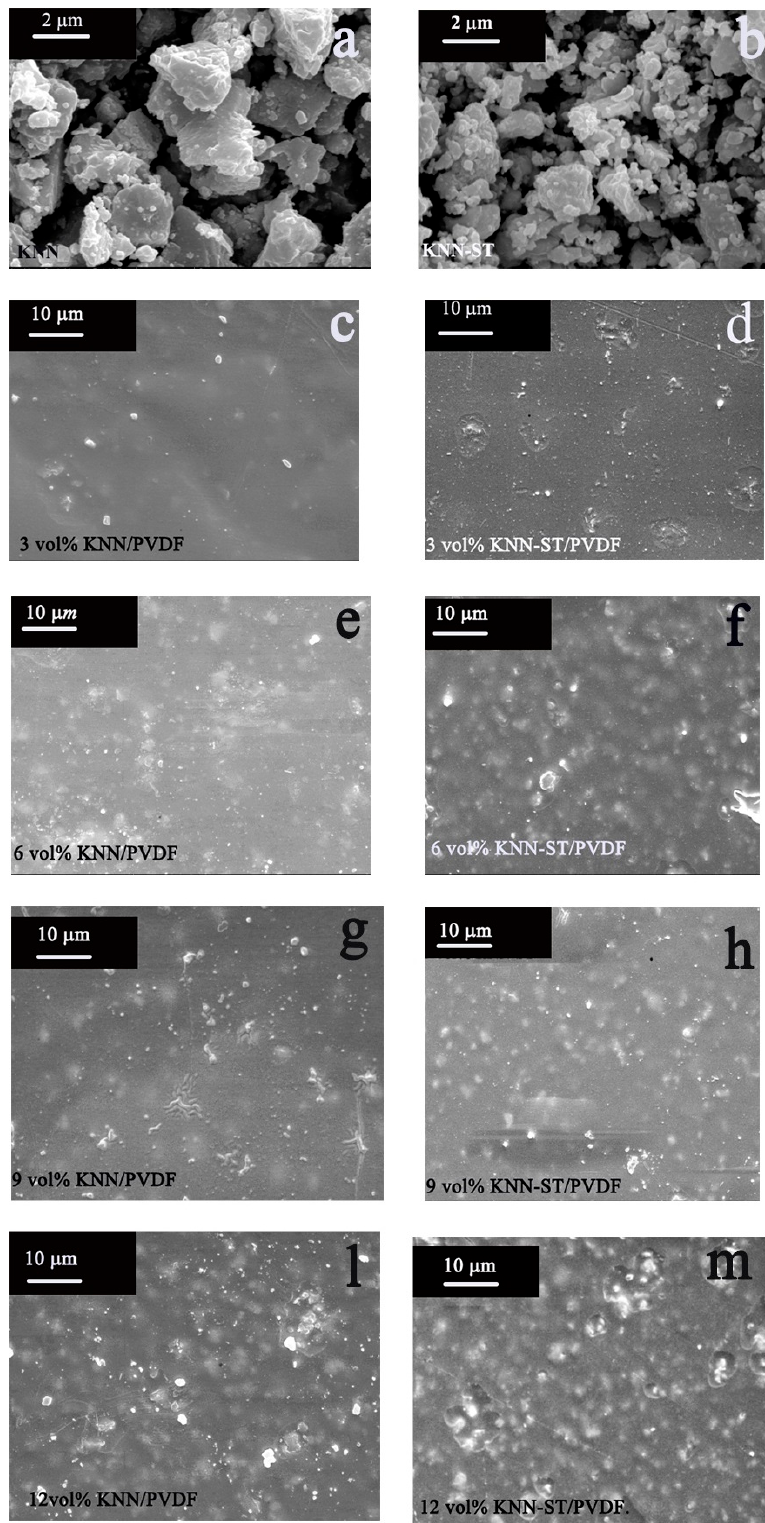
Figure 3. Surface SEM microtopographies of KNN particles, KNN-ST particles, KNN/ polyvinylidene fluoride (PVDF) and KNN-ST/PVDF composite films: ( a )KNN particles; ( b ) KNN-ST particles; ( c ) 3 vol% KNN/PVDF; ( d ) 3 vol% KNN-ST/PVDF; ( e ) 6 vol% KNN/PVDF; ( f ) 6 vol% KNN-ST/PVDF; ( g ) 9 vol% KNN/PVDF; ( h ) 9 vol% KNN-ST/PVDF; ( l ) 12vol% KNN/PVDF; ( m ) 12 vol%